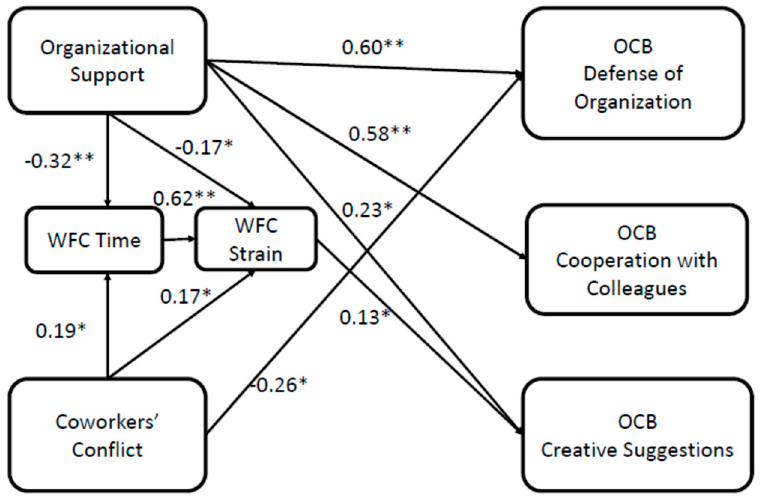
Figure 1. Path model (* p < 0.05 and ** p < 0.001).